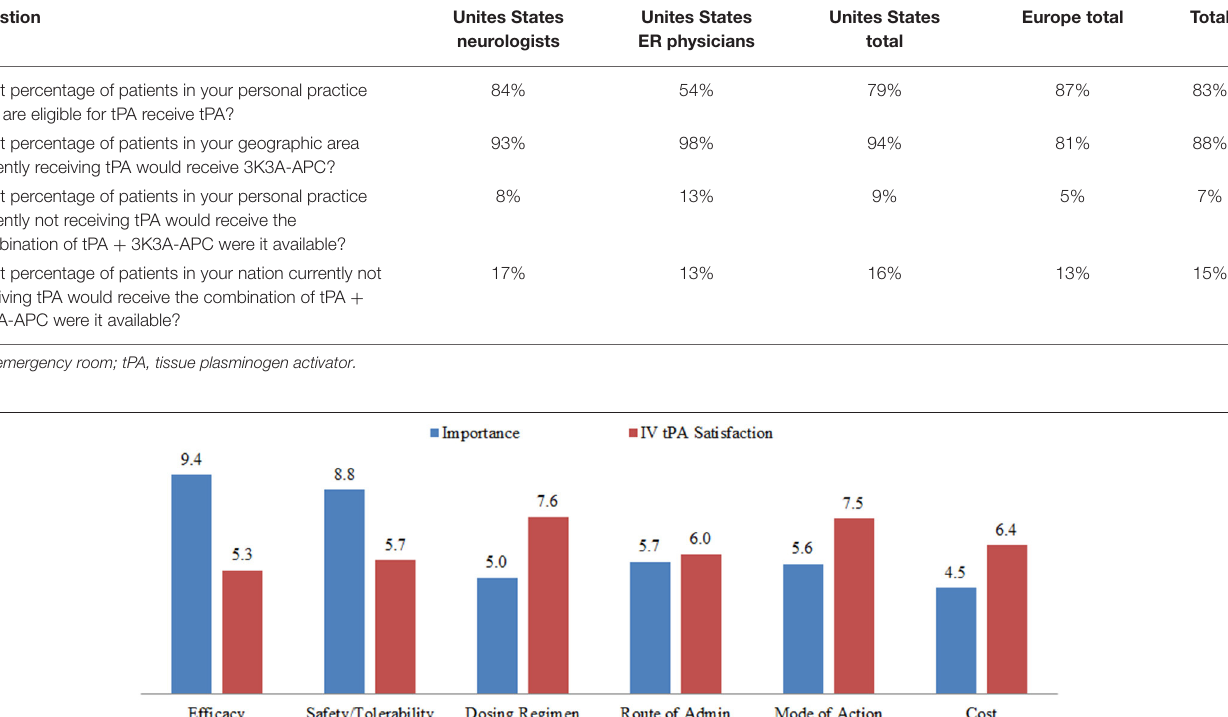
Frontiers in Neurology |